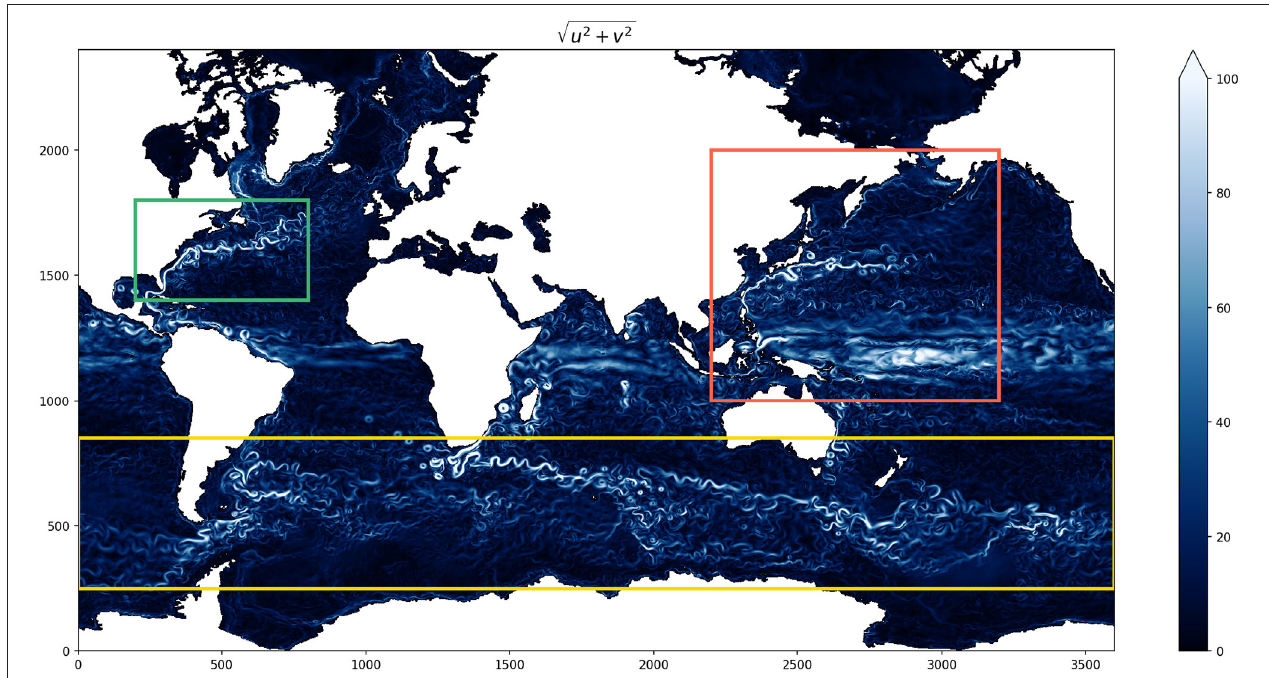
FIGURE 2 | Snapshot of the surface speed in the CESM POP model with the three boxes in different colors indicating the training regions chosen for the different regression models. The green box is chosen as the Gulf stream region, the red box is Kuroshio and the yellow box represents the Southern Ocean/Antarctic circumpolar current (ACC). The Kuroshio region extends slightly south of the equator to include the equatorial jets in the domain and to test the models’ ability to generalize to large variations in